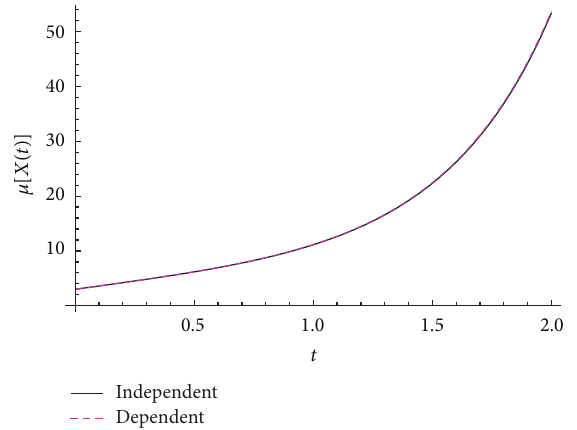
Figure 5: Comparison of the approximations for the expectation 𝜇[𝑋(𝑡)] on the time-interval 𝑡 ∈ [0,2] in Example 4 by using Fr¨obenius and Polynomial Chaos. The numerical values obtained by both techniques are indistinguishable graphically. We assume that 𝜂 = (𝐴, 𝑌 0 ,𝑌 1 ) ⊤ follows a multivariate Gaussian distribution: ; Σ ) where 𝜇 = (−2,3, 6) ⊤ and Σ 1 Σ 2 𝜂 ∼ 𝑁( 𝜇 𝜂 𝜂 𝜂 𝜂 and 𝜂 are given by (35) corresponding to statistical independence and dependence, respectively.